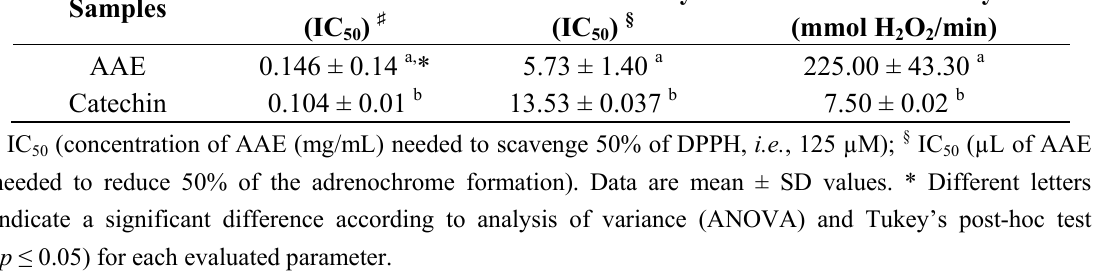
Table 1 . In vitro antioxidant activity of the Araucaria angustifolia extract (AAE). Samples